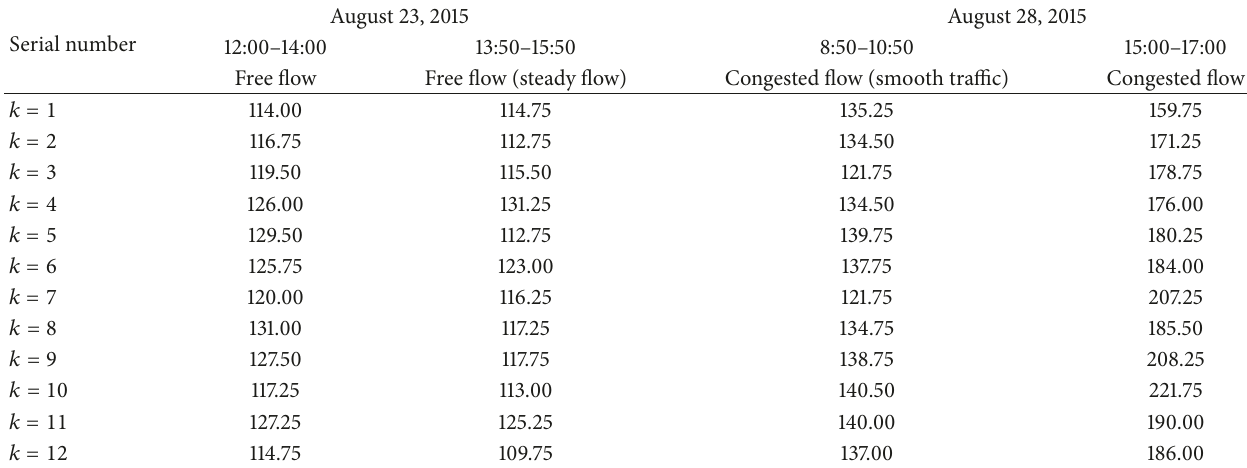
Table 1: Four sections of a road traffic flow in Canada on August 23 and on August